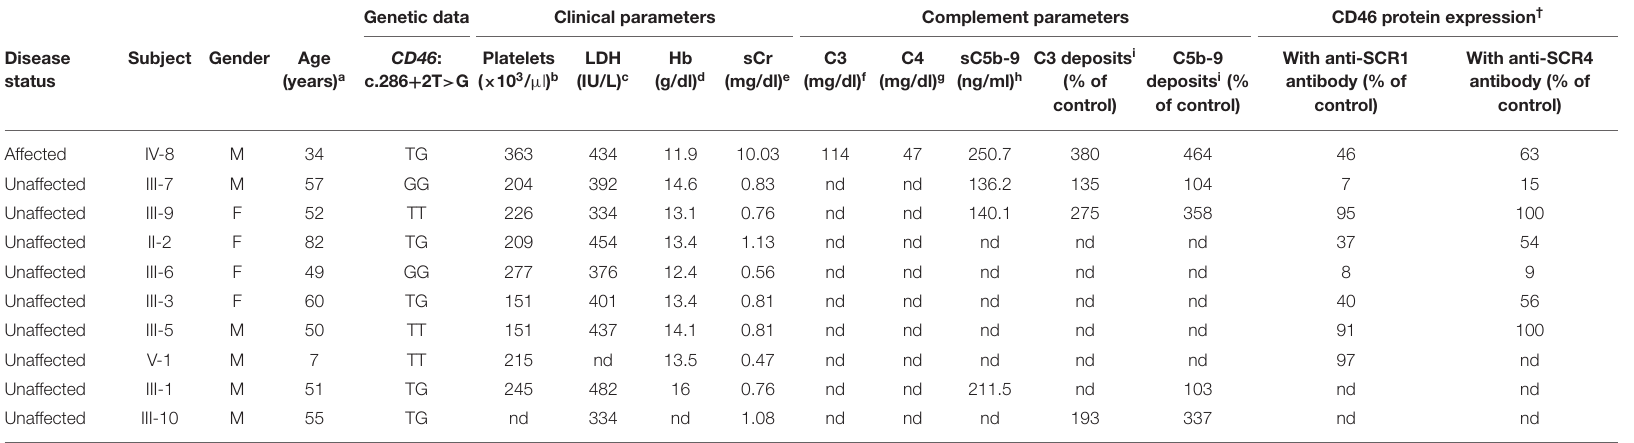
TABLE 2 | Clinical, complement, genetic, and CD46 expression data in the patient and his asymptomatic relatives. Genetic data Clinical parameters Complement parameters CD46 protein expression